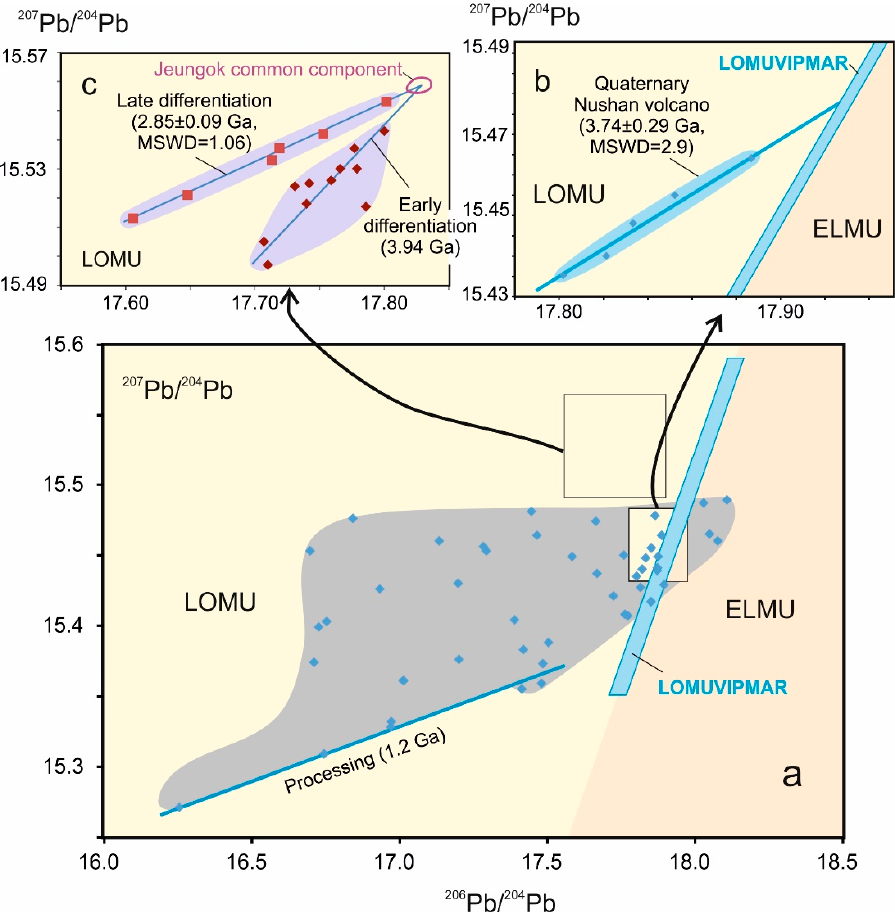
Figure 6. Diagrams of 207 Pb/ 204 Pb versus 206 Pb/ 204 Pb for volcanic rocks from the Anhui province ( a ), Quaternary volcano Nushan of this province ( b ), and Jeungok volcanic field ( c ). In diagrams a and b, the LOMUVIPMAR composition and LOMU – ELMU discriminating line are shown as in Figure 5. In diagrams b and c, calculations of the secondary errochron 3.74 Ga and secondary isochron 2.85 Ga, respectively, were performed using the Isoplot program [87]. The Jeungok common component shows relatively radiogenic Pb. Data are from [51,56,88,89].